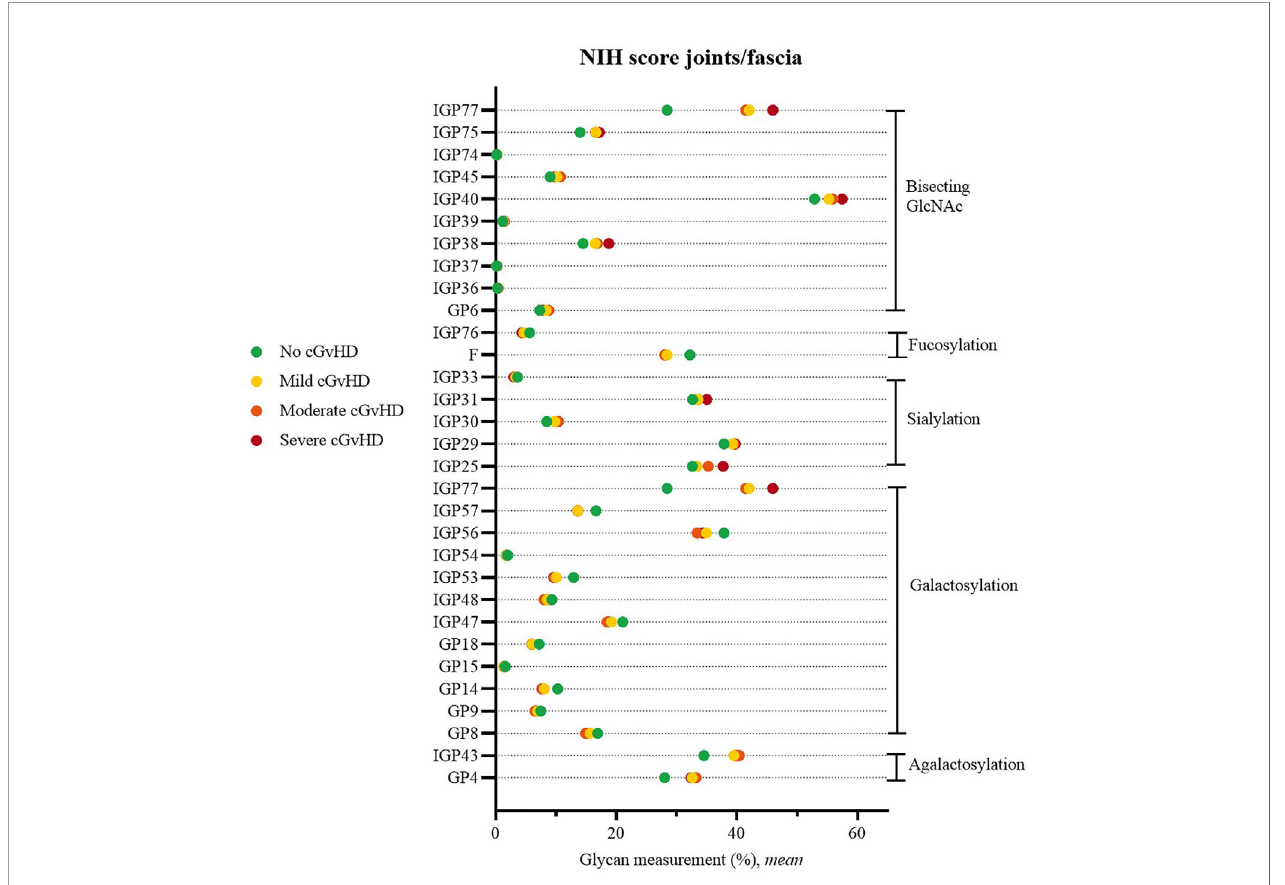
FIGURE 1 | Signi fi cant differences in glycan measurements in patients with no joint/fascia cGvHD and among various degrees of joint/fascia NIH cGvHD